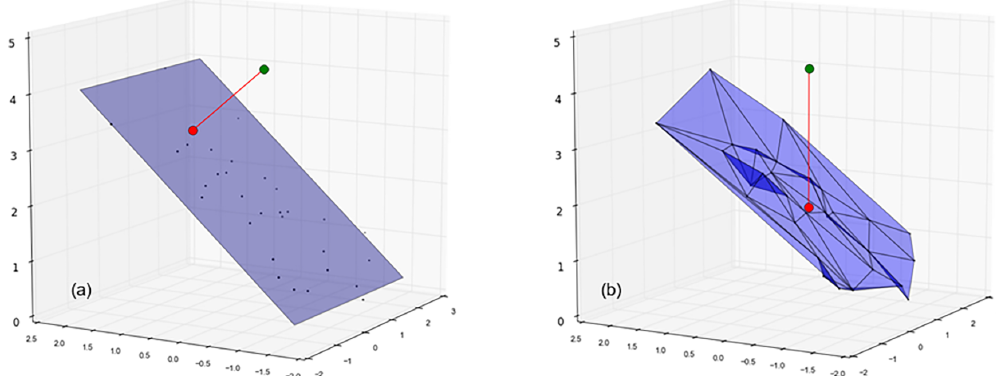
Figure 5. Schematic representation of the positional accuracy analysis. Black dots represent the reference dataset (lidar) and the green circle represents the point being evaluated from photogrammetry. (a) Red circles represent the normal projection of the green point onto the tangential plane fitted to the reference dataset and (b) the vertical projection of the green point into the three-dimensional reference triangular irregular network